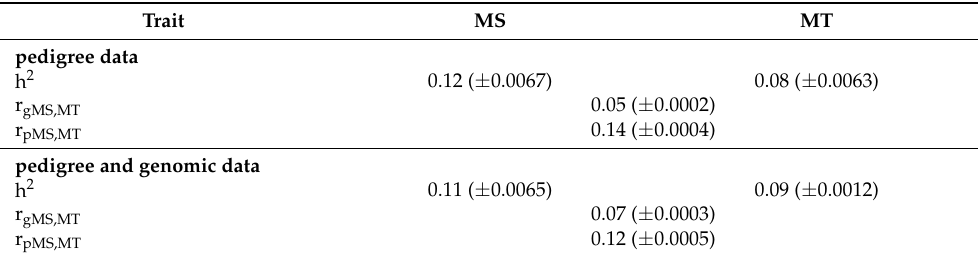
Table 6. Genetic and phenotypic parameters of workability traits based on conventional data and conventional and genomic data.